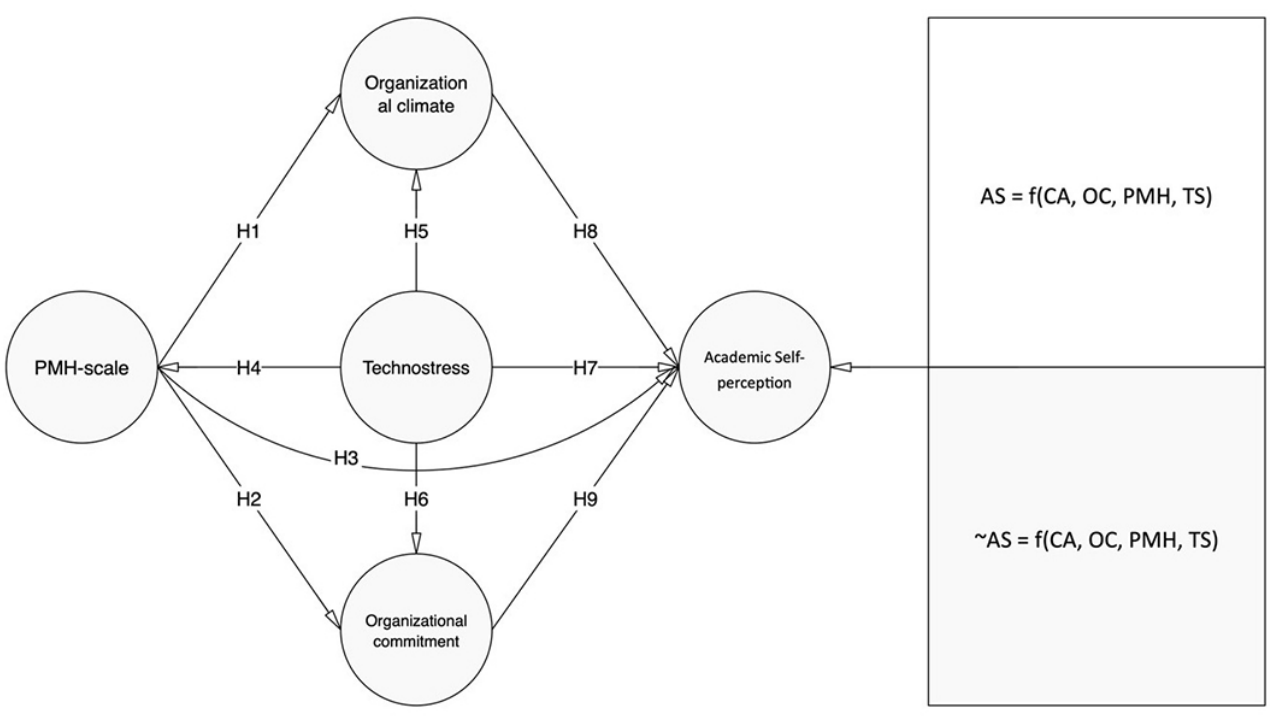
FIGURE 1. Proposed model. AS: Academic Self-perception; CA: Organizational commitment; OC: Organizational Climate; PMH: Positive Mental Health; TS: